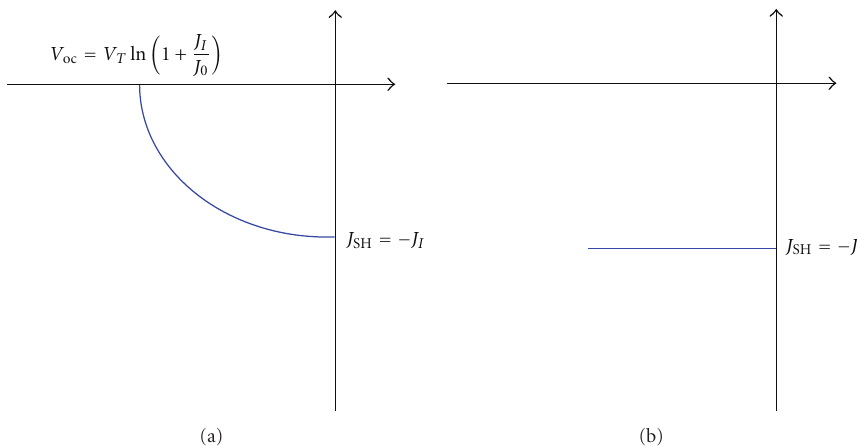
Figure 2: J - V characteristic of an ideal solar cell with the short- and open-circuit expressions for the axis-intercept points V oc and J SH , respectively, (a). J - V characteristic in the limiting case of a thin-film cell l n,p (cid:2) L n,p